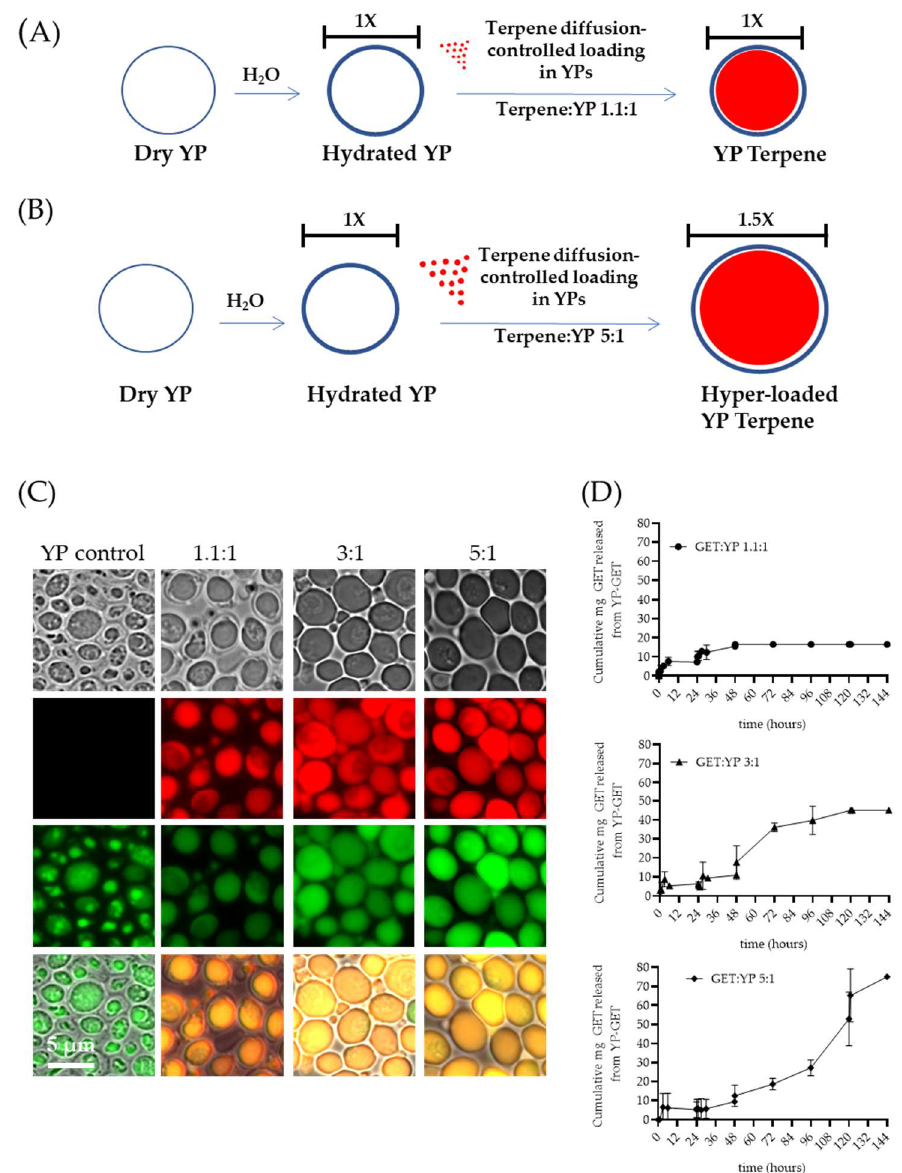
Figure 4. Schematics of diffusion-controlled terpene loading in YPs at terpene:YP ratios of ( A ) 1.1:1 and ( B ) 5:1. ( C ) Microscopy images showing FITC–concanavalin A stained YPs and Nile red stained terpenes in empty YP control and YP GETs loaded at GET:YP ratios of 1.1:1, 3:1, and 5.1. ( D ) Cumulative GET release from YPs showing extension of wetting/terpene release cycles in YP GET 1.1:1 and hyper-loaded YP GET at ratios of 3:1 and 5:1 GET:YP. Figures adapted from Reference [40] and reproduced with permission from MDPI .